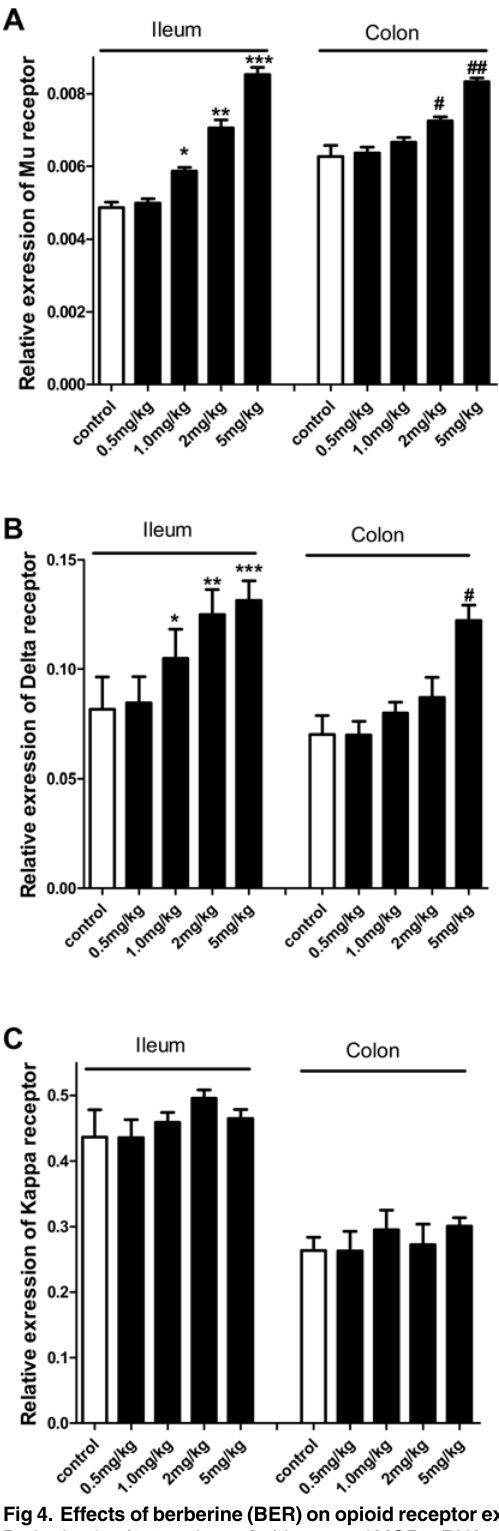
Fig 4. Effects of berberine (BER) on opioid receptor expression in the mouse ileum and colon. A: Berberine i . p . (1, 2 and 5 mg/kg) increased MOR mRNA expression in the mouse ileum in a dose-dependent manner, and berberine i . p . (2 and 5 mg/kg) increased MOR expression in the mouse colon. * P <